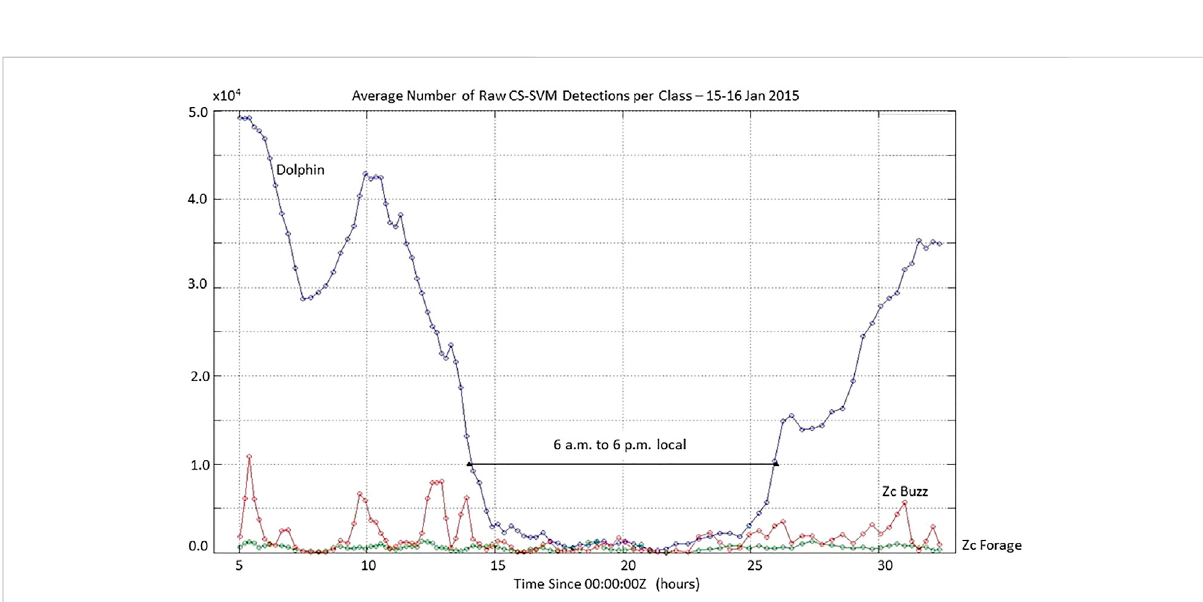
FIGURE 9 Number of raw CS-SVM click detections per class over a 29 h period on 15 – 16 January 2015 shows an over 10 fold increase in dolphin click activity at night which may obscure the identi fi cation of some Zc group dives and buzzes at